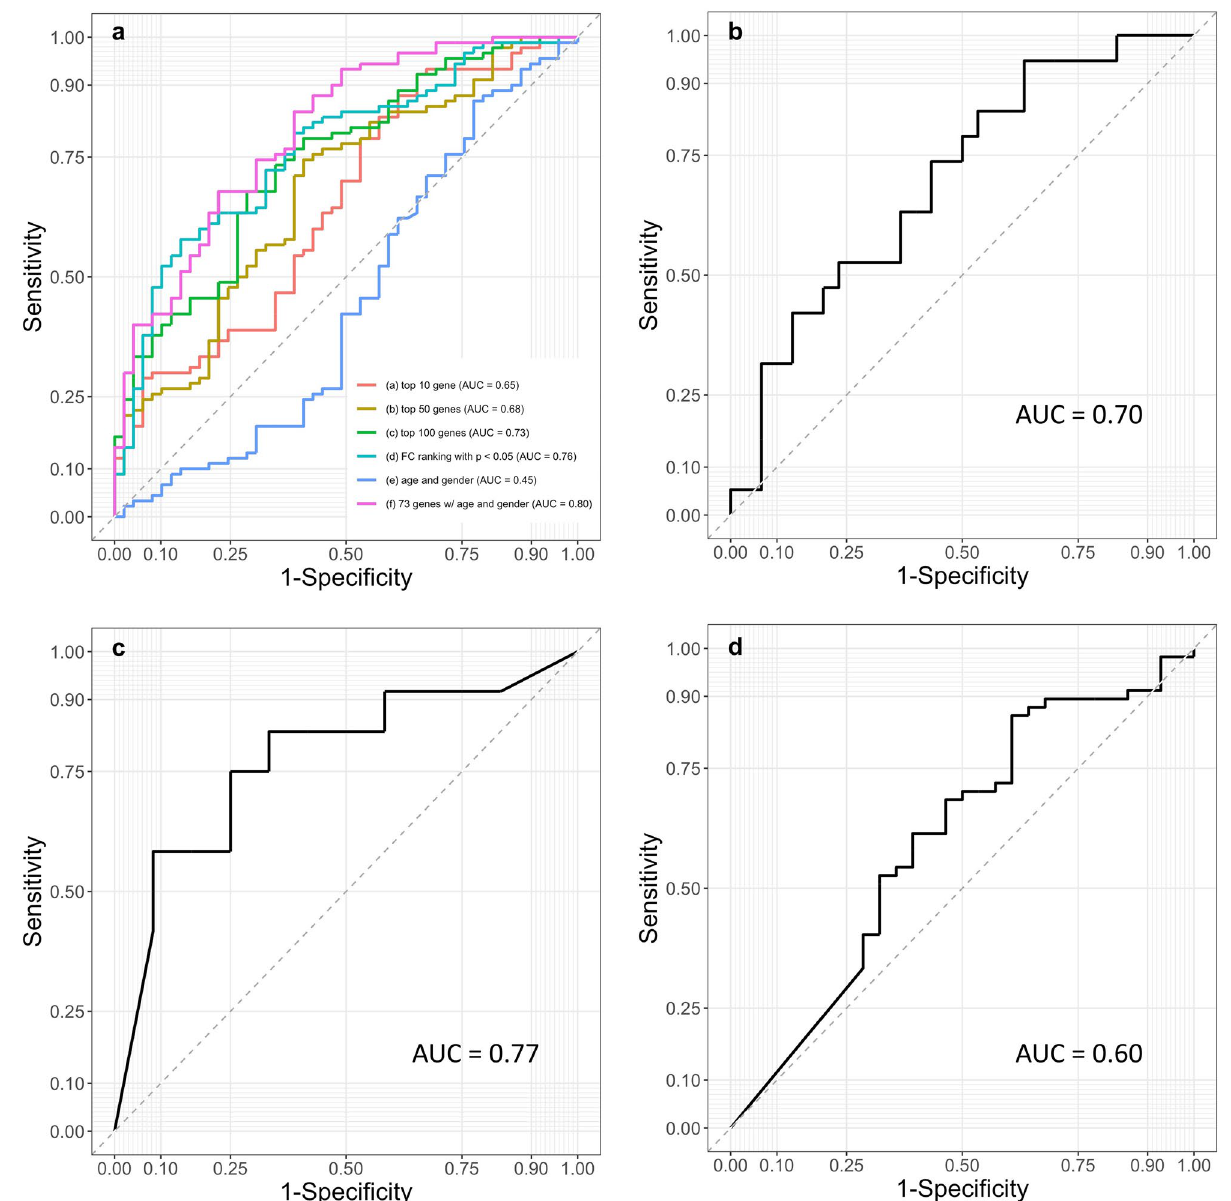
Figure 5. ROC curves for the asthma prediction performance of RSRS. ( a ) testing set and comparison with risk scores based on the DEG list ranked by fold change (FC) with p < 0.05, and the top 10, 50,100 genes ranked by p value; ( b ) in the independent cohort GSE118761 (AUC = 0.70); ( c ) in the independent cohort GSE38003 (AUC = 0.77); ( d ) in the independent cohort GSE85567 (AUC =